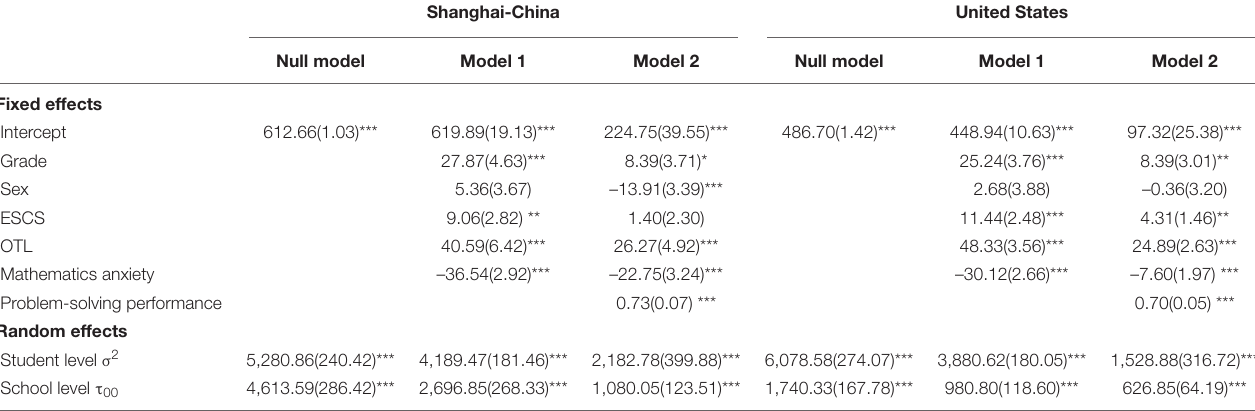
TABLE 4 | Effects of OTL on student mathematics